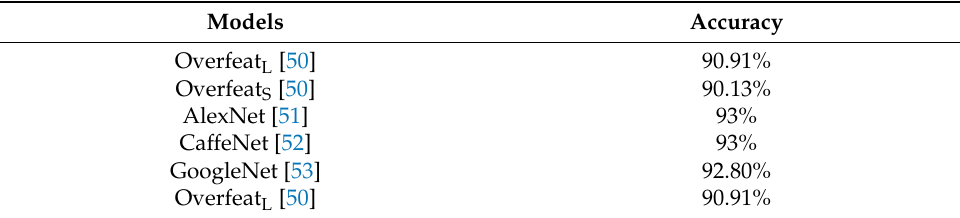
Table 5. Accuracy of the assessed models on Brazilian coffee fields.